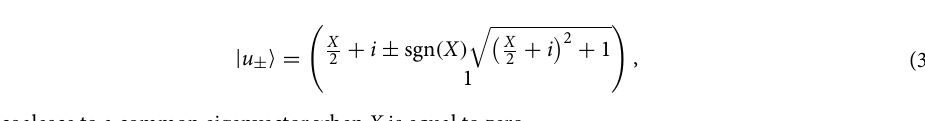
X 0.4 ). Red and black solid curves are � � = 0.02, τ c 1 / g , g √ σ X τ c 0.14 . The = = ≃ constant / x =